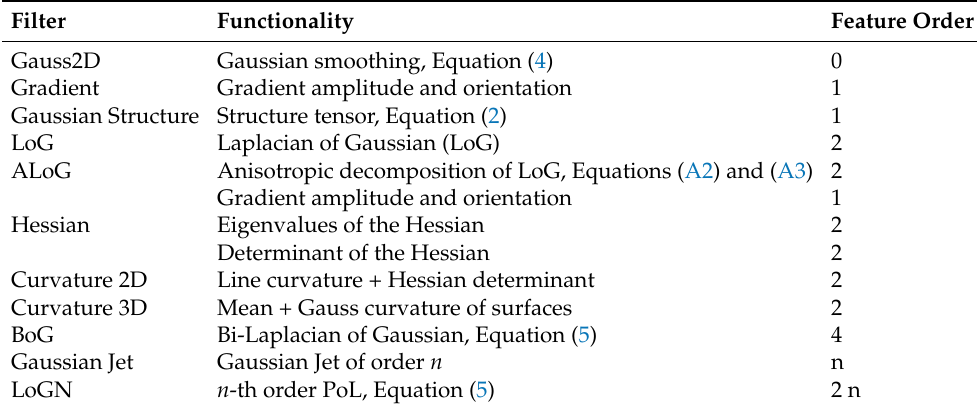
Table 3. Filters computing geometric